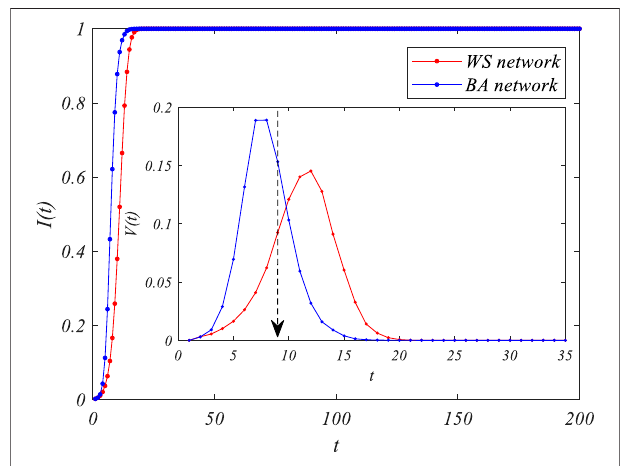
FIGURE2| Thesusceptible – infected(SI)epidemicspreadingprocessin differentnetworks, β (cid:1) 0 . 3. I ( t )representsthefractionofinfectednodesattime t and V ( t ) the growth rate of infection at time t.